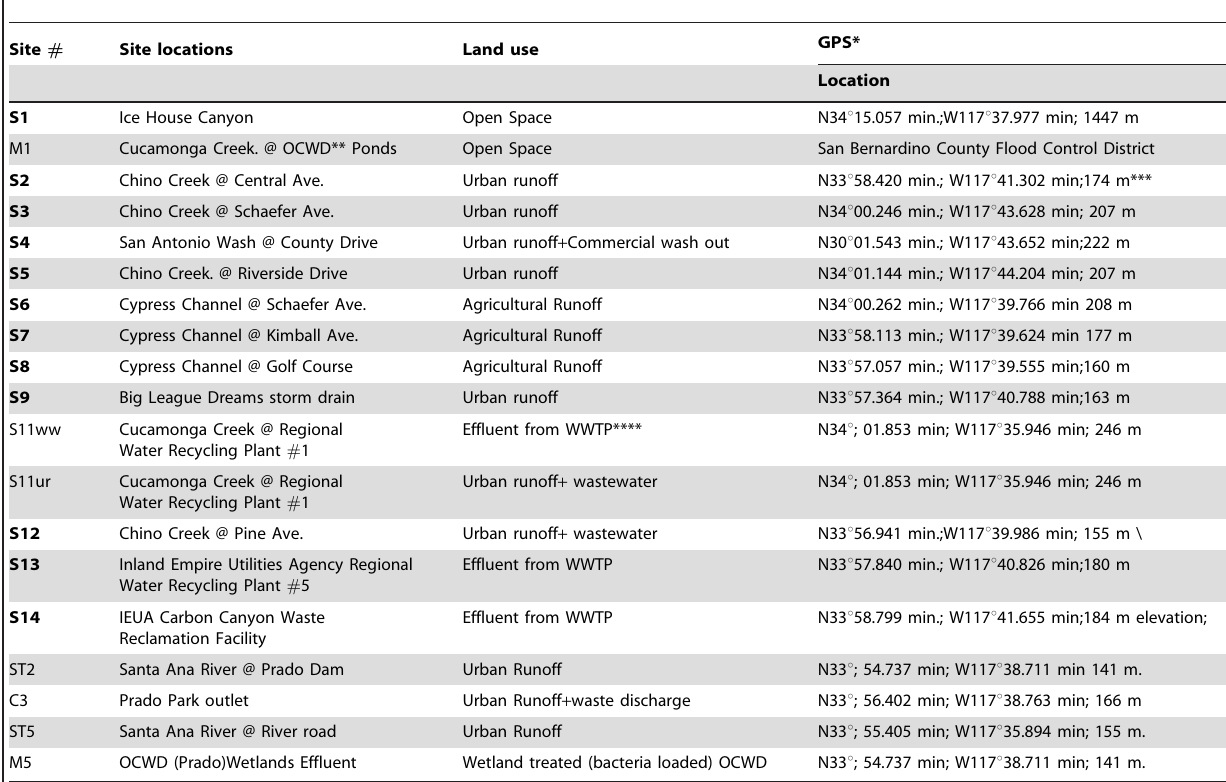
Table 1. Sampling locations for middle Santa Ana River pathogen source evaluation